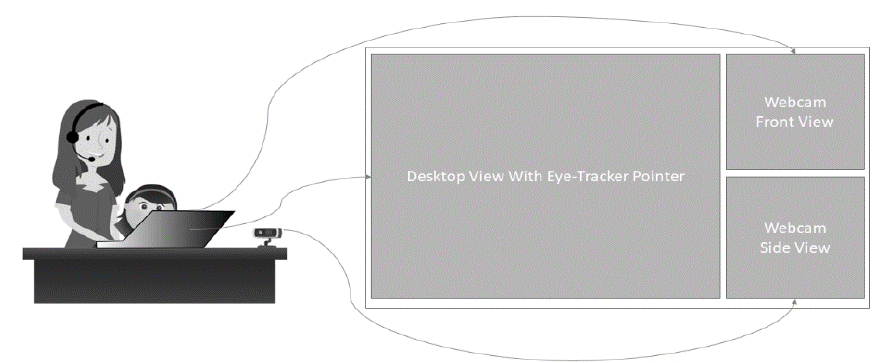
Figure 2. Local workstation setting (left) for cognitive telerehabilitation session, with acquired video for videoconferencing (right).